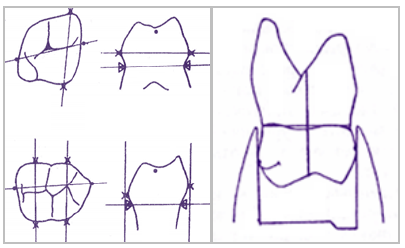
Figure 1. Guidelines for measurements on tooth